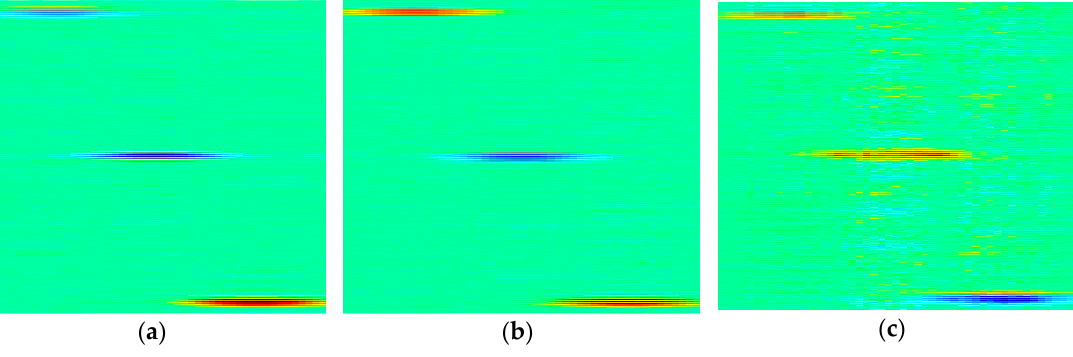
Figure 4. The recovery results of 25 MHz SR simulated image in time domain, ( a ) Compression ratio (CR) = 50%, PSNR = 45.05 dB; ( b ) CR = 60%, PSNR = 43.99 dB; ( c ) CR = 70%, PSNR = 36.71 dB.